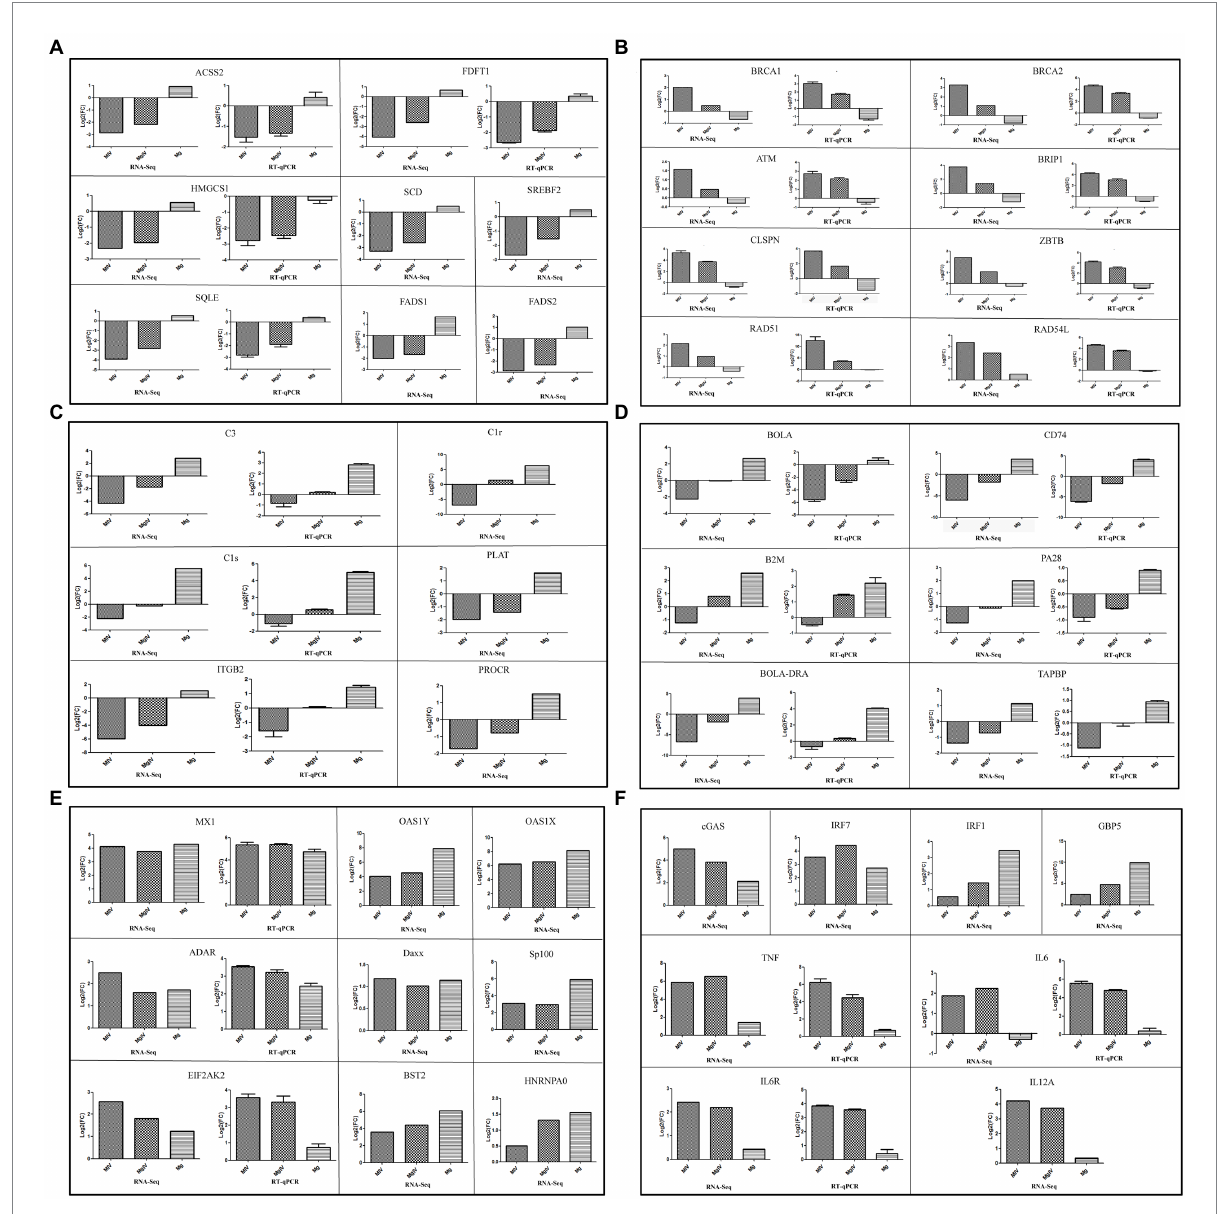
FIGURE 5 Expression level of genes related to lipid metabolism, DNA damage and repair, interferon stimulation genes, complement and coagulation signalling cascades, antigen processing and presentation, interferon regulatory factors and pro-inflammatory cytokines. ACSS2, FDFT1, HMGCS1, SQLE, BACA1, BACA2, ATM, BRIP1, CLSPN, ZBTB, RAD51, RAD54L, C3, C1S, ITGB2, BoLA, CD74, B2M, PA28, BoLA-DRA, TAPBP, MX1, ADAR, EIF2AK2, TNF, IL6, and IL6R validated by RT-qPCR. (A) Expression level of genes related to lipid metabolism. (B) Expression level of genes related